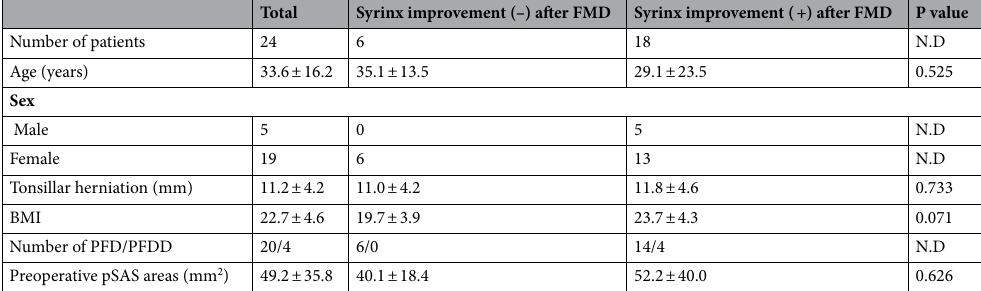
Table 2. Characteristics of the CM1 patients with syrinx after FMD. N.D., not determined.